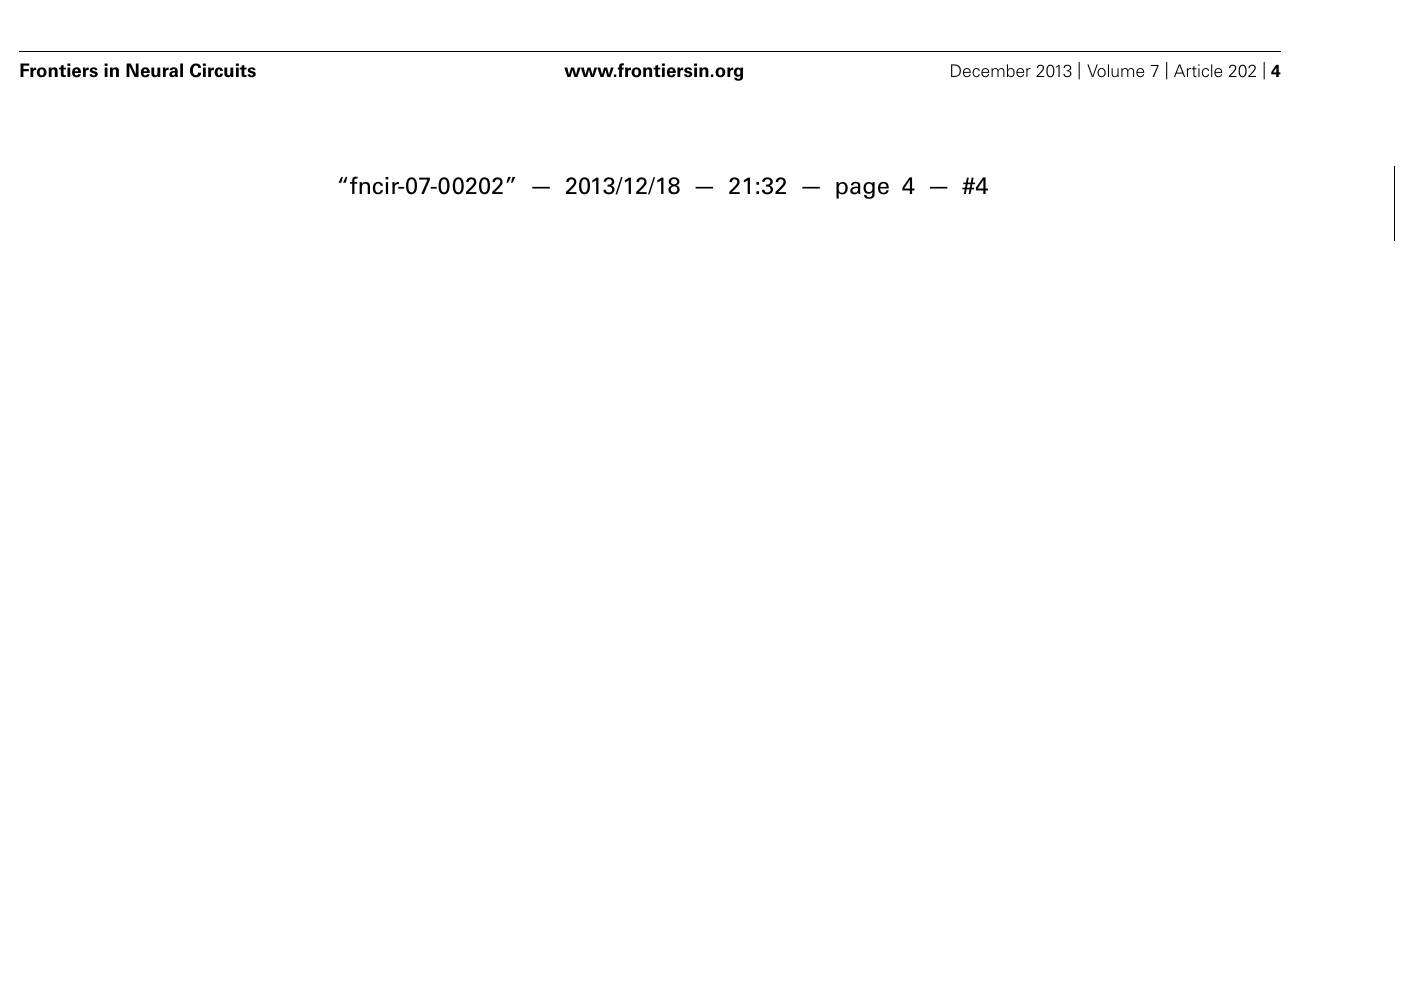
pial surface for control cultures (green) and cultures treated with BDNF (gray). (E) Reconstructions of representative axons from thalamic cells in the neocortical explant and a histogram showing the distribution of axonal branch points with respect to the pial surface. Branch-point density = number of branch points/number of axons. (F) Reconstructions of representative axons from thalamic cells in the neocortical explant when BDNF was added to the medium. A histogram plotting the distribution of the axonal branch points with respect to the pial surface is shown on the